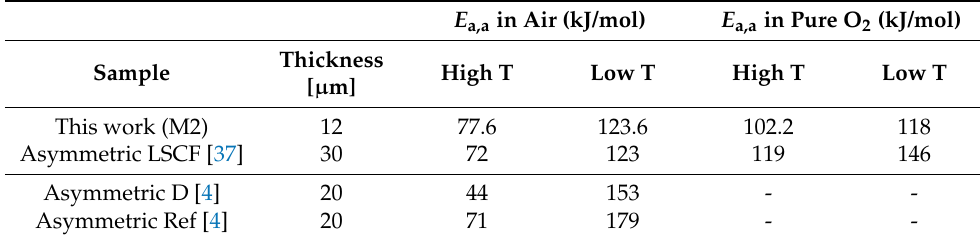
Table 3. Comparison between apparent activation energy values.